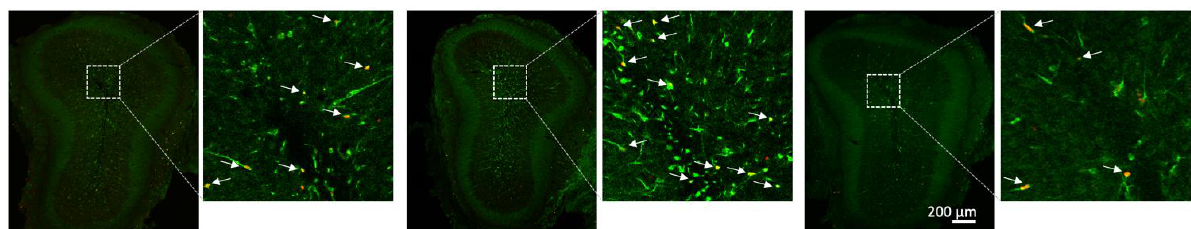
Figure 7. Adult neurogenesis in SVZ-RMS-OB axis following short-term ICV infusion of D-Pen. ( A ). Proliferation in the SVZ following short term ICV infusion of D-Pen. Proliferative NSPSs were Ki67(+)/Nestin(+). Scale bar = 200 μm. ( B ). Quantification of Ki67(+)/Nestin(+) cells per brain based on confocal 3D reconstruction. Data represent mean ± SD, n = 3/group; ** p < 0.01 as compared with the saline-infused controls. ( C ). DCX(+)/BrdU(+) newborn neuroblasts in the RMS from sagittal slices following short term ICV infusion of D- Pen. Scale bar = 100 μm. ( D ). Quantification of DCX(+)/BrdU(+) newborn neuroblasts per brain based on confocal 3D reconstruction. Data repre- sent mean ± SD, n = 3/group; *** p < 0.001 as compared with the saline-infused controls. ( E ). Newborn neuroblast arrival at OB following short term D-Pen infusion. Newborn neuroblasts were DCX(+)/BrdU(+) marked by white arrows. Scale bar = 200 μm. ( F ). Quantification of DCX(+)/BrdU(+) newborn neuroblasts at OB per brain based on confocal 3D reconstruction. Data represent mean ± SD, n = 3/group. * p < 0.05, ** p < 0.01, as compared with the saline-infused